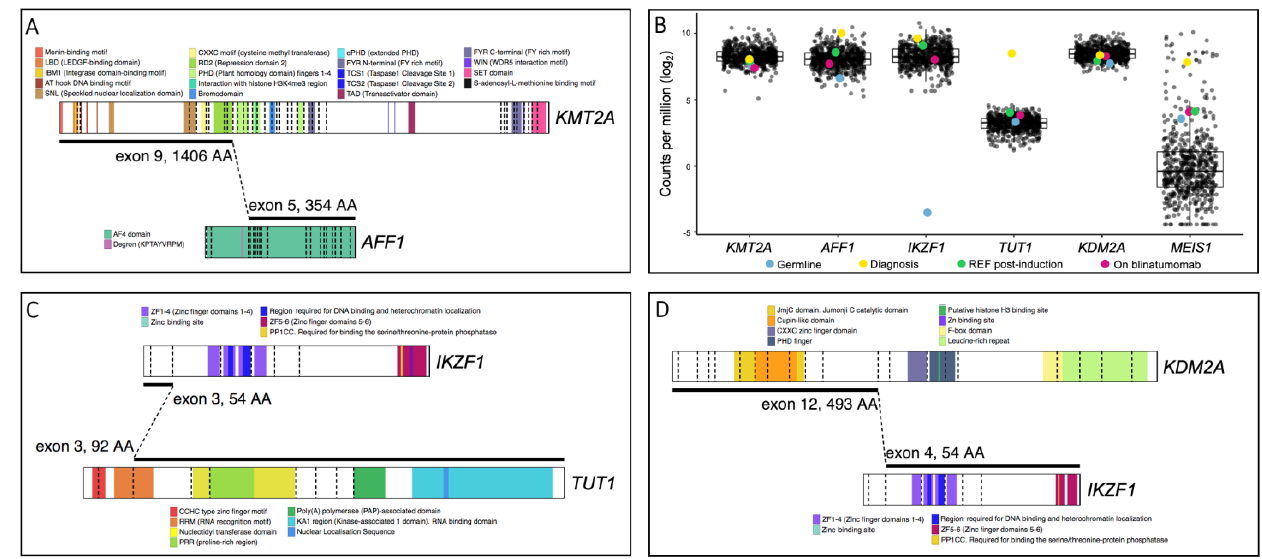
Figure 3. Schematic representations of the KMT2A::AFF1 , IKZF1::TUT1 and KDM2A::IKZF1 gene fusions were created using ProteinPaint [14]. ( A ) The KMT2A::AFF1 gene fusion retains DNA- and